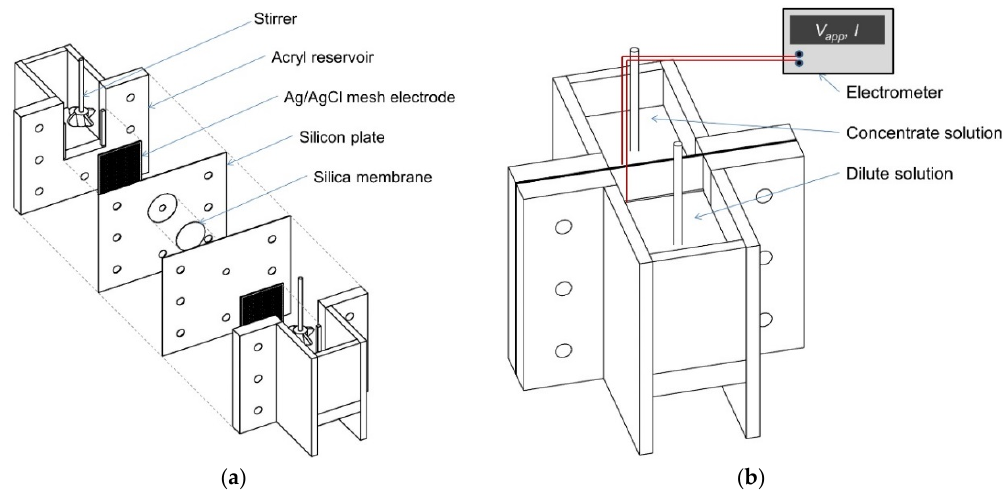
Figure 4. Experimental setup: ( a ) enlarged schematic and ( b ) normal schematic.